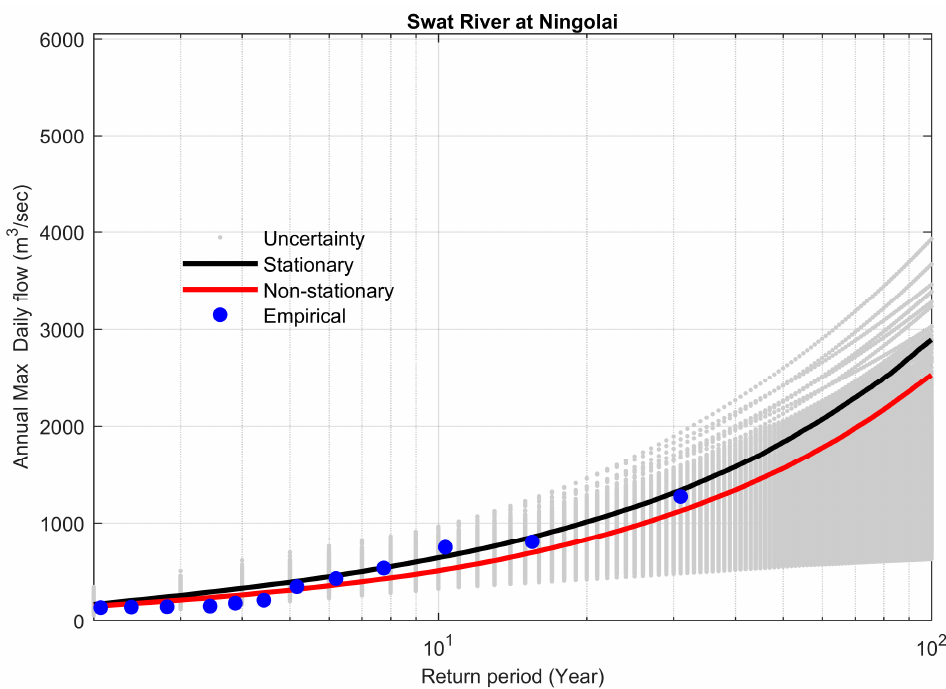
Figure 4. Comparison between non-stationary and stationary FFCs at site 11, along with non-stationary uncertainty bounds for the year 2016.